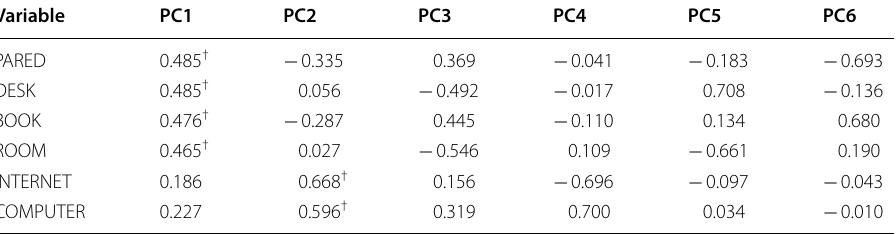
Table 6 Factor loadings from principal components analysis of family socio‑economic